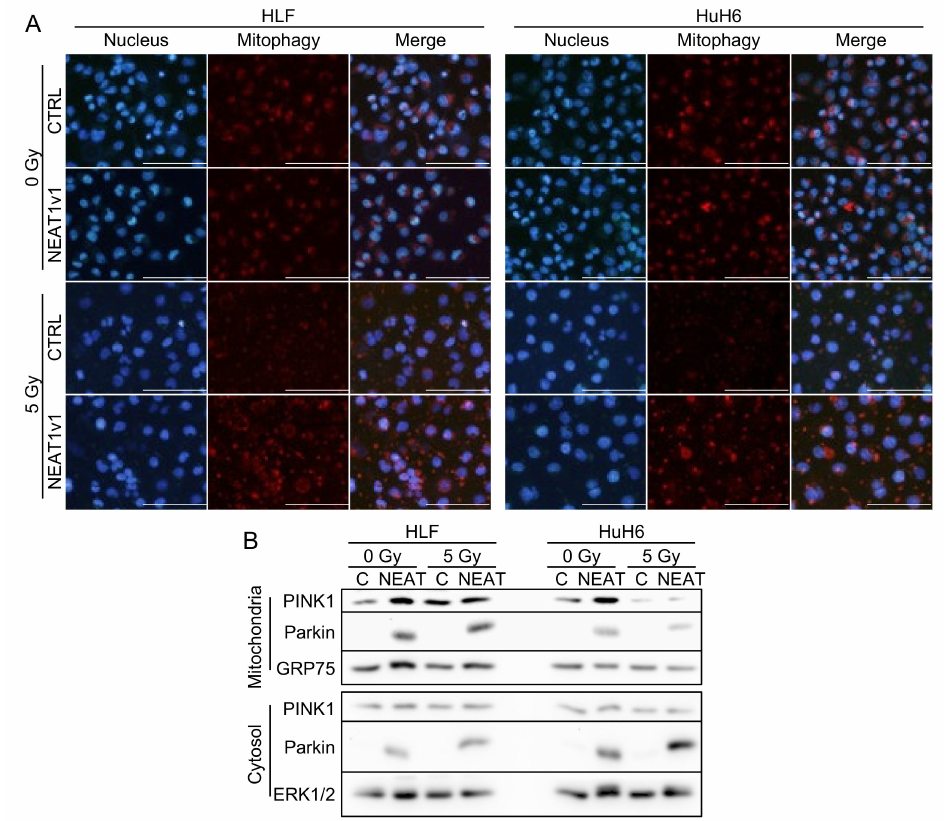
Figure 2. Induction of PINK1/parkin-mediated mitophagy by NEAT1v1 in irradiated cells. ( A ) Rep- resentative images of mitophagy staining. Mitophagy was stained with Mitophagy Dye (red). Nuclei were counterstained with Hoechst (blue). Scale bar, 100 µ m. ( B ) Representative Western blot im- ages for mitochondrial and cytosolic PINK1, parkin, GRP75 (mitochondrial marker), and ERK1/2 (cytosolic marker). C, CTRL; NEAT, NEAT1v1-overexpressing